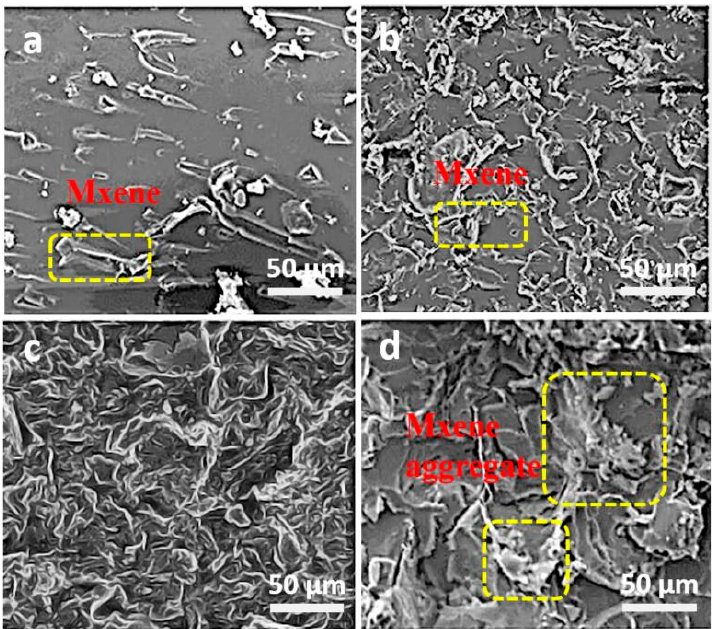
Figure 9. The fracture surfaces of the EP/Ti 3 C 2 T x MXene nanosheets composite containing 0.4 wt % Ti 3 C 2 T x MXene nanosheets ( a ), 0.8 wt % Ti 3 C 2 T x MXene nanosheets ( b ), 1.2 wt % Ti 3 C 2 T x MXene nanosheets ( c ), and 1.6 wt % Ti 3 C 2 T x MXene nanosheets ( d ).